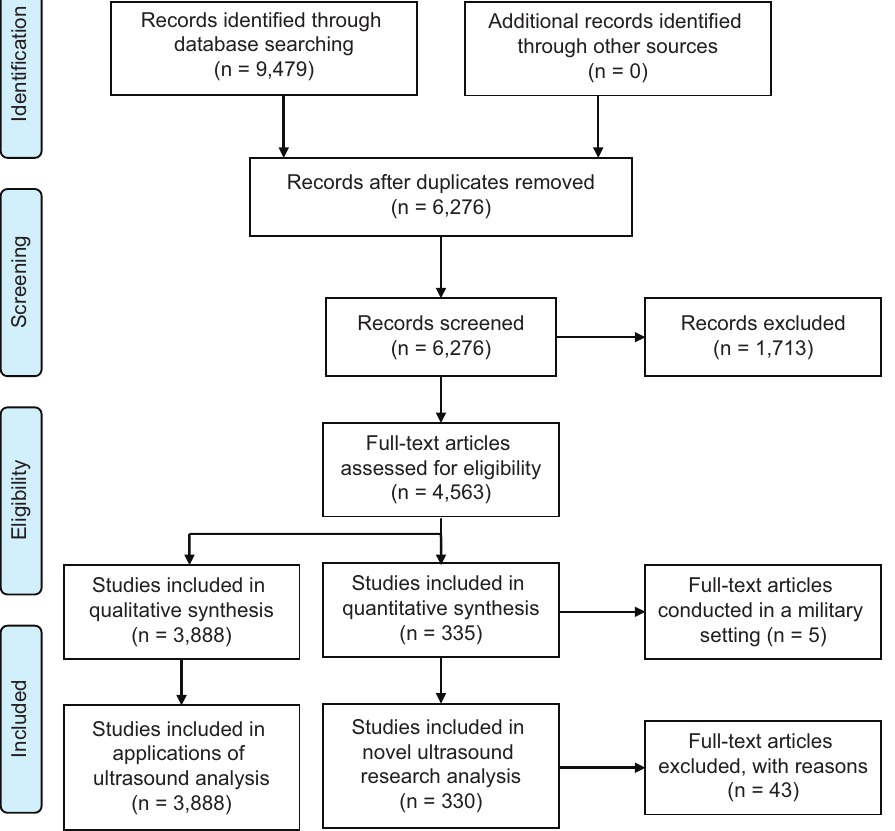
Figure 1: PRISMA flow diagram Novel: designates novel ultrasound research studies (n=287); Application: designates all applications of ultrasound studies included in review